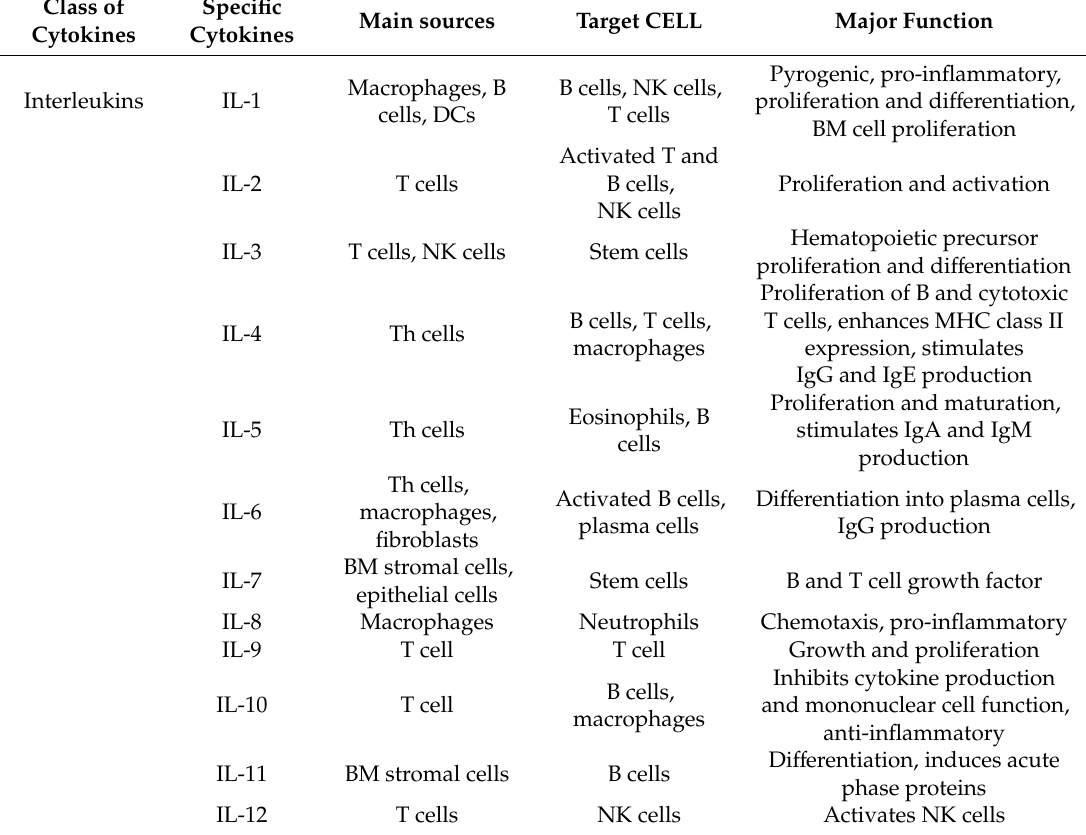
Table 2. Specific roles of individual cytokines that depend on cell type and location